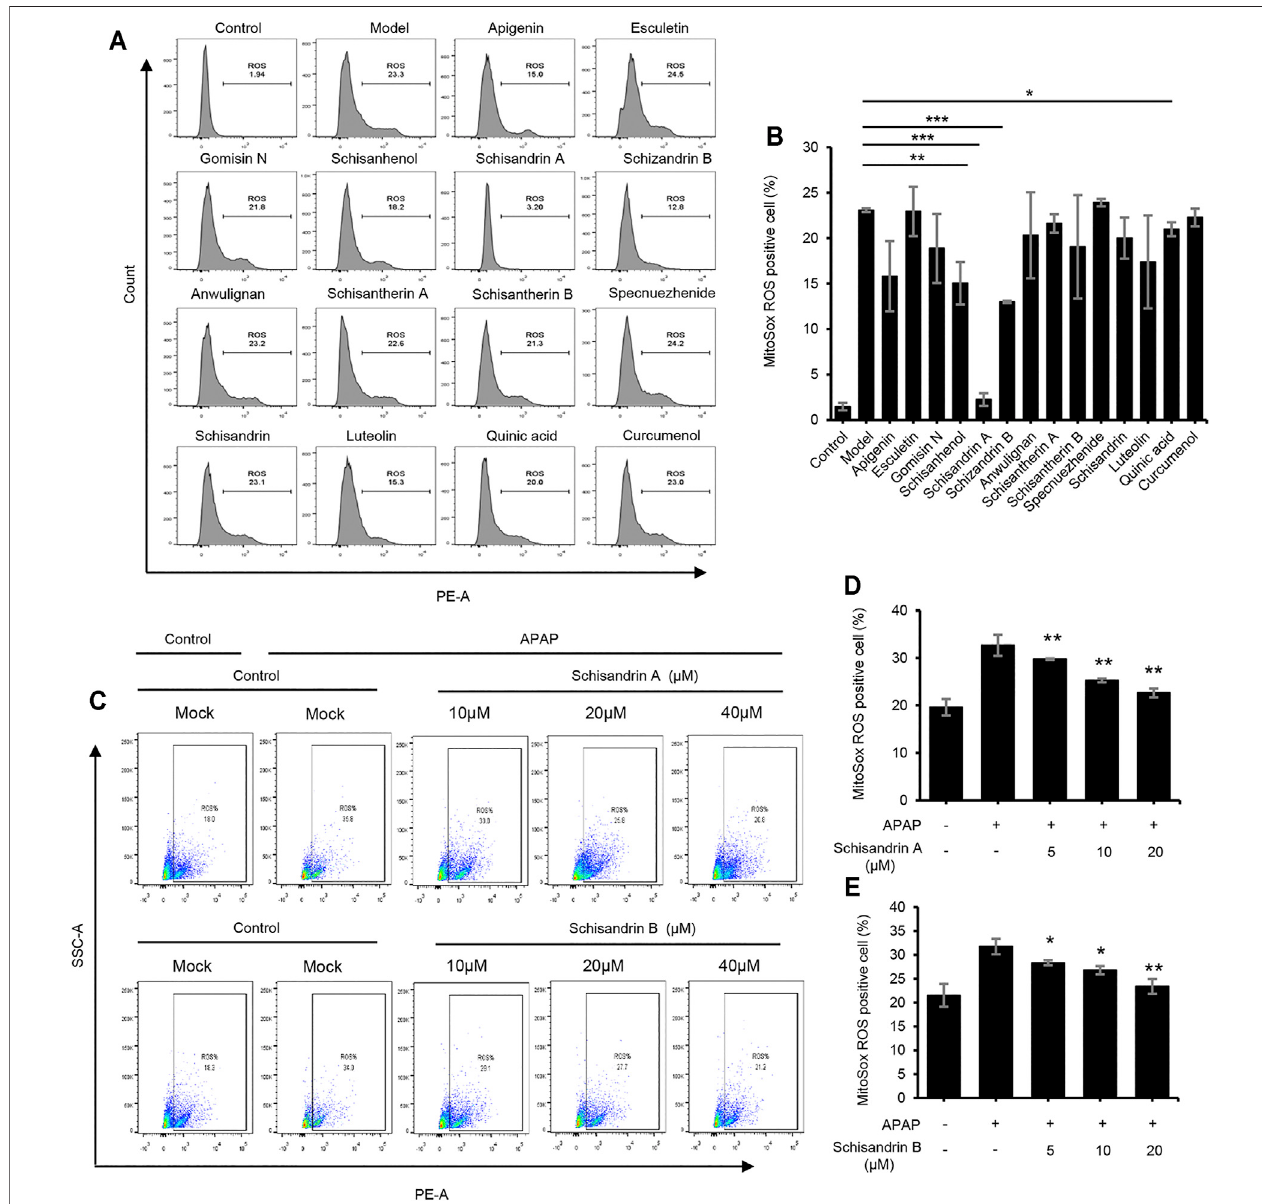
FIGURE 6 | Schisandrin A and schisandrin B inhibit the release of ROS. (A) HepaG2 cells were treated with apigenin, esculetin, gomisin N, schisanhenol, schisandrin A, schisandrin B, anwulignan, schisantherin A, schisantherin B, specnuezhenide, schisandrin, luteolin, quinic acid, and curcumenol (40 μ M) before being stimulatedwithAPAP.HepaG2wereloadedwithMitoSOXredmitochondrialsuperoxideindicator(Ex/Em:510/580 nm).Afterstainingandwashing, fl owcytometrywas conducted to test mtROS production. (B) Percentage of ROS-positive cells in HepaG2 cells from samples described in A. (C) The production of mtROS was detected by fl ow cytometry in HepaG2 cells treated with schisandrin A or schisandrin B (10, 20, and 40 μ M). (D,E) Percentage of ROS-positive cells in HepaG2 cells pretreatedwithschisandrinA (D) orschisandrinB (E) (10,20,and40 μ M)andthenstimulatedwithAPAP,followedbystainingwithMitoSox.Dataarerepresentedasthe mean ± SDusing biologicalsamples.The signi fi cance ofthedifferences wasanalyzed using unpaired Student ’ st-test: *p < 0.05, **p < 0.01, ***p < 0.001 vs. thecontrol, NS, not signi fi cant.